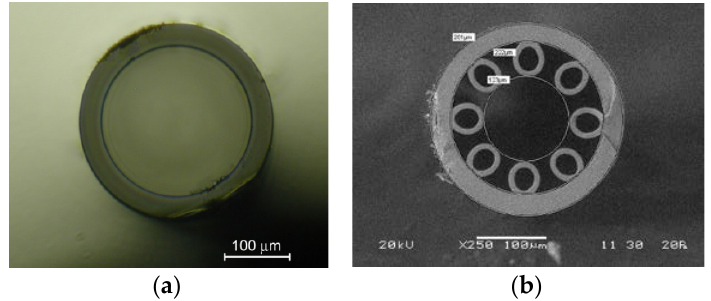
Figure 4. Pictures of the cross section of the capillary and HCF used in these experiments: ( a ) silica glass capillary with an internal diameter of 230 μm (optical microscope picture); ( b ) revolver HCF with a core diameter of 120 μm, taken with an electron microscope.